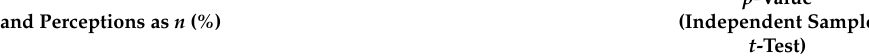
Table 2. Knowledge and perceptions of